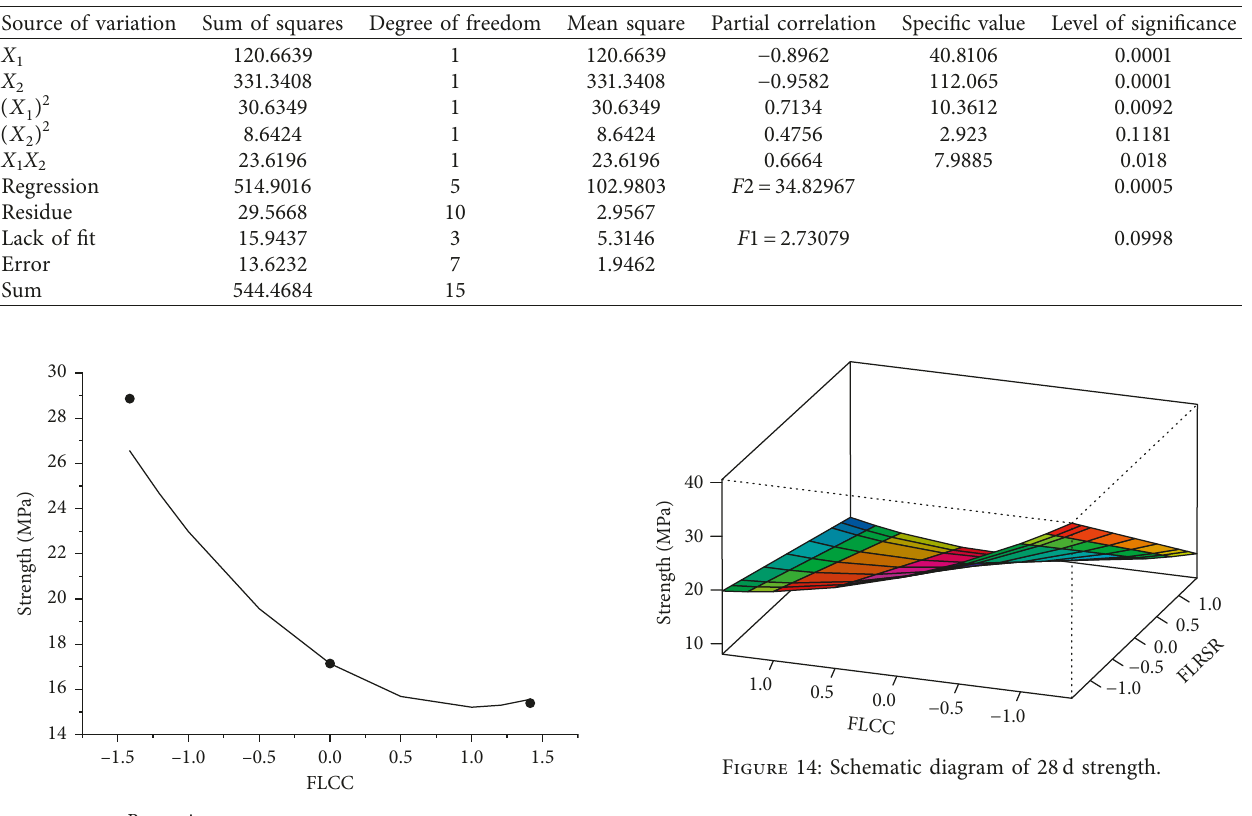
Table 10: Variance analysis of the 28d strength of the mortar.